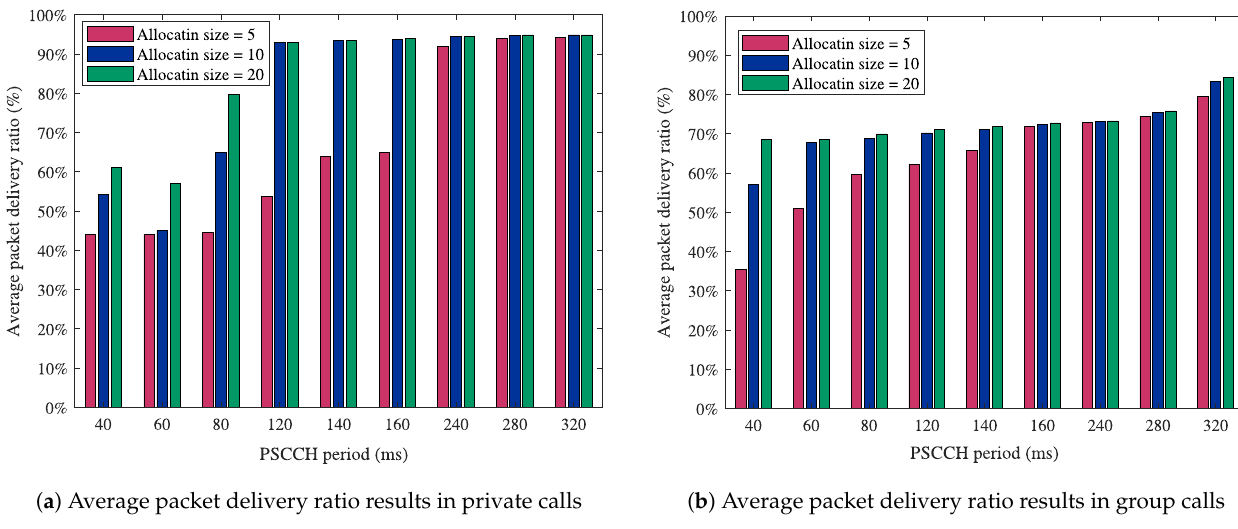
Figure 7. Impact of the sidelink allocation size on reliability performance in MCPTT